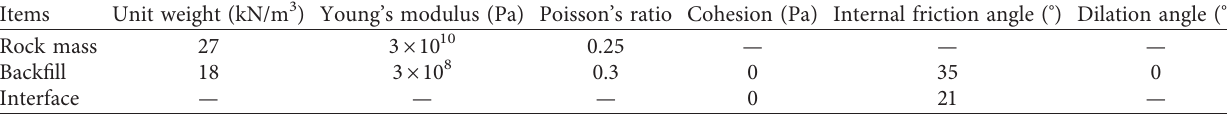
Table 1: A summarize of fixed parameters in all numerical models.